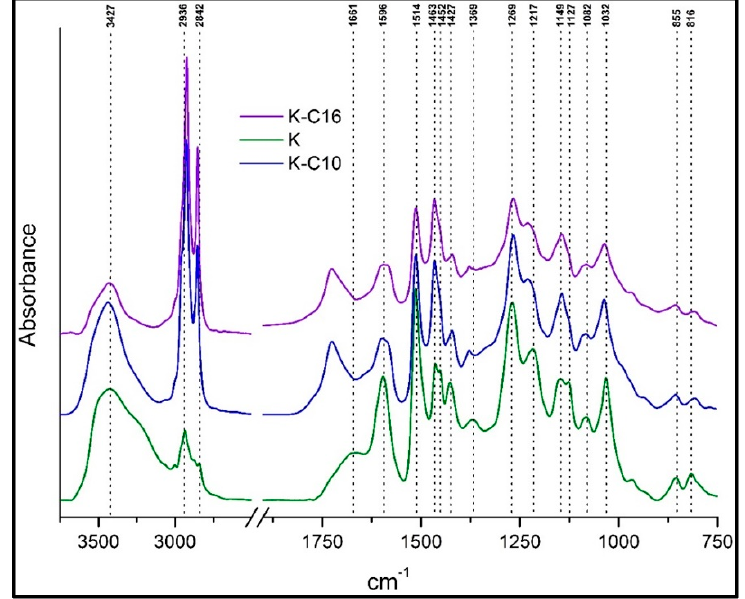
Figure 2. FT-IR spectra of nonfunctionalized Kraft (K) lignin etherified with C10 (K-C10) and C16 alkyl chains.